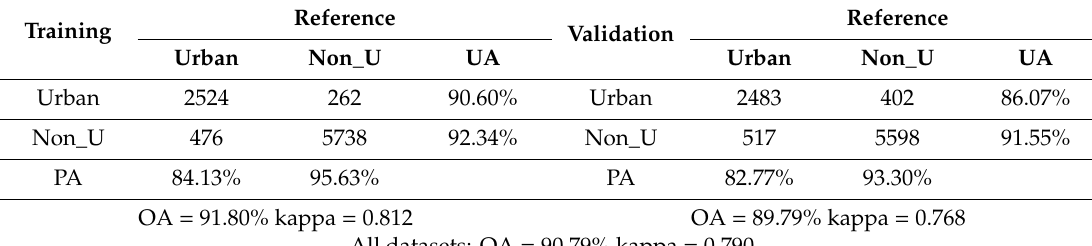
Table 4. A classification confusion matrix for the two categories Urban and Non-Urban (Non_U), based on the training dataset and the validation dataset, including User’s accuracy (UA), Producer’s accuracy (PA), Overall accuracy (OA), and the kappa coe ffi cient.